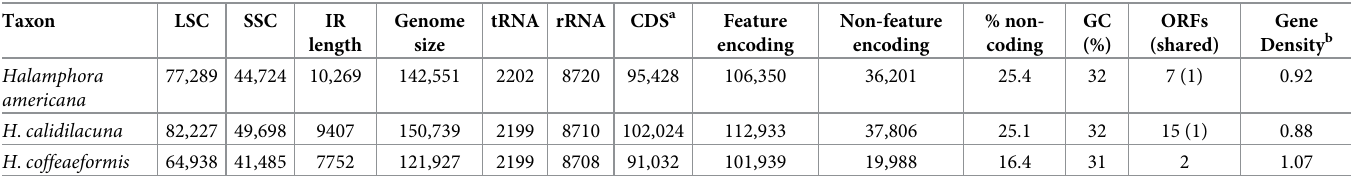
Table 2. Quantification of features in three Halamphora species, including % non-coding sequence, % GC, the number of ORFs (the number of ORFs shared by > 1 Halamphora genome), and gene